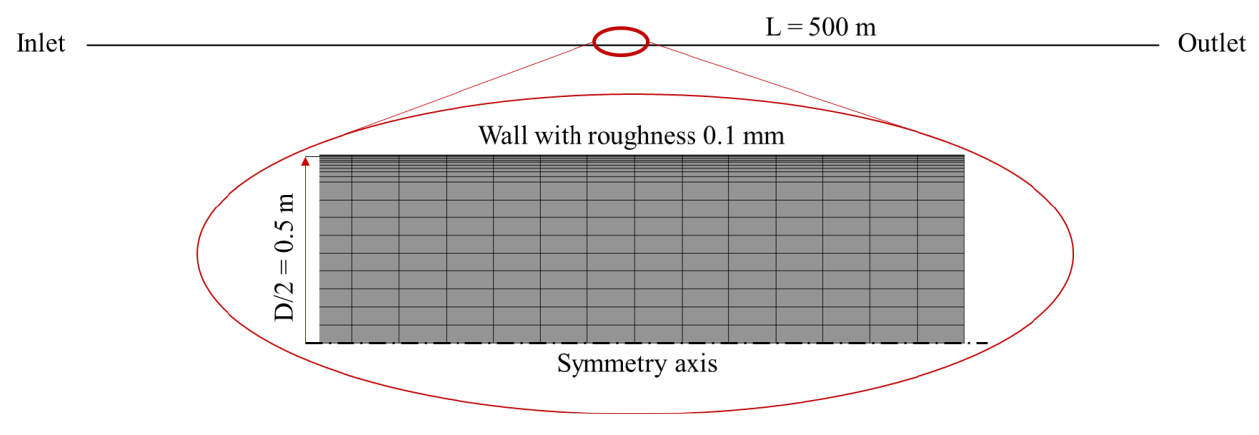
Figure 3. Simulation domain of the axis symmetric pipe segment.